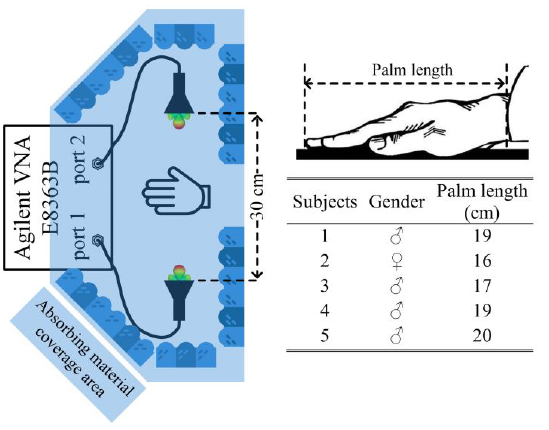
Figure 12. The localized hand palm channel for the five test subjects